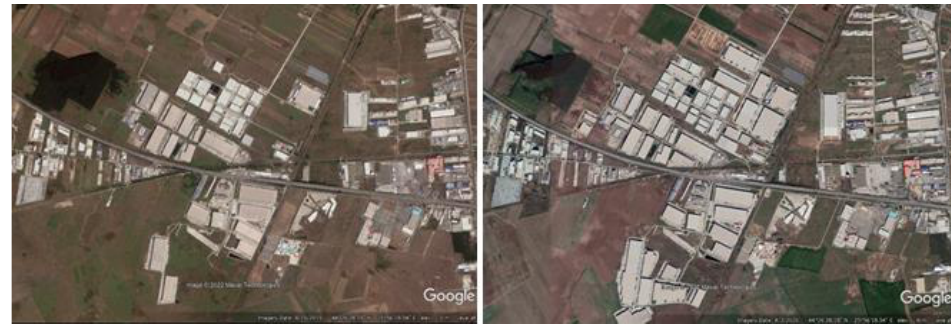
Figure 9. Expansion of an industrial area in Dragomireşti Vale, Bucharest : 2015 ( left ) and 2020 ( right ).